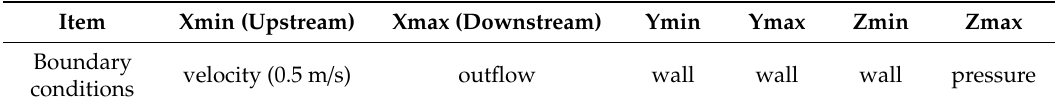
Table 3. Boundary conditions of the model. 135